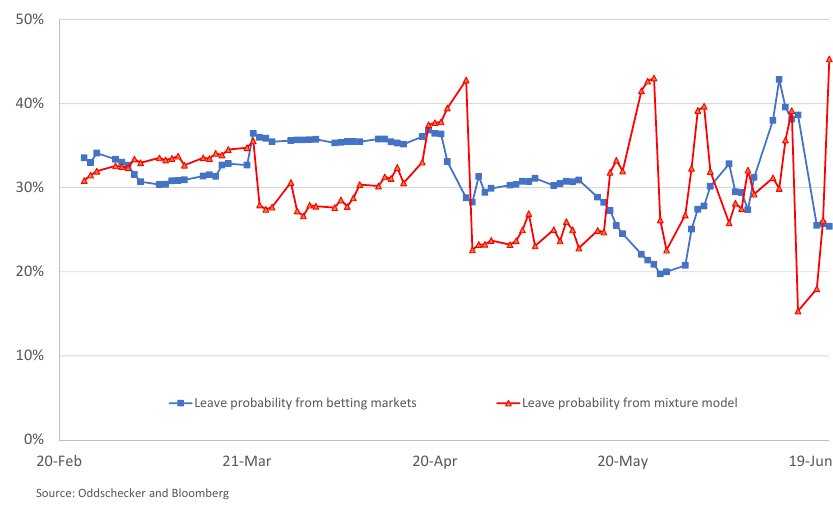
Figure 8. Comparison of “leave” probabilities obtained from betting odds and from the mixture model (24 February to 22 June